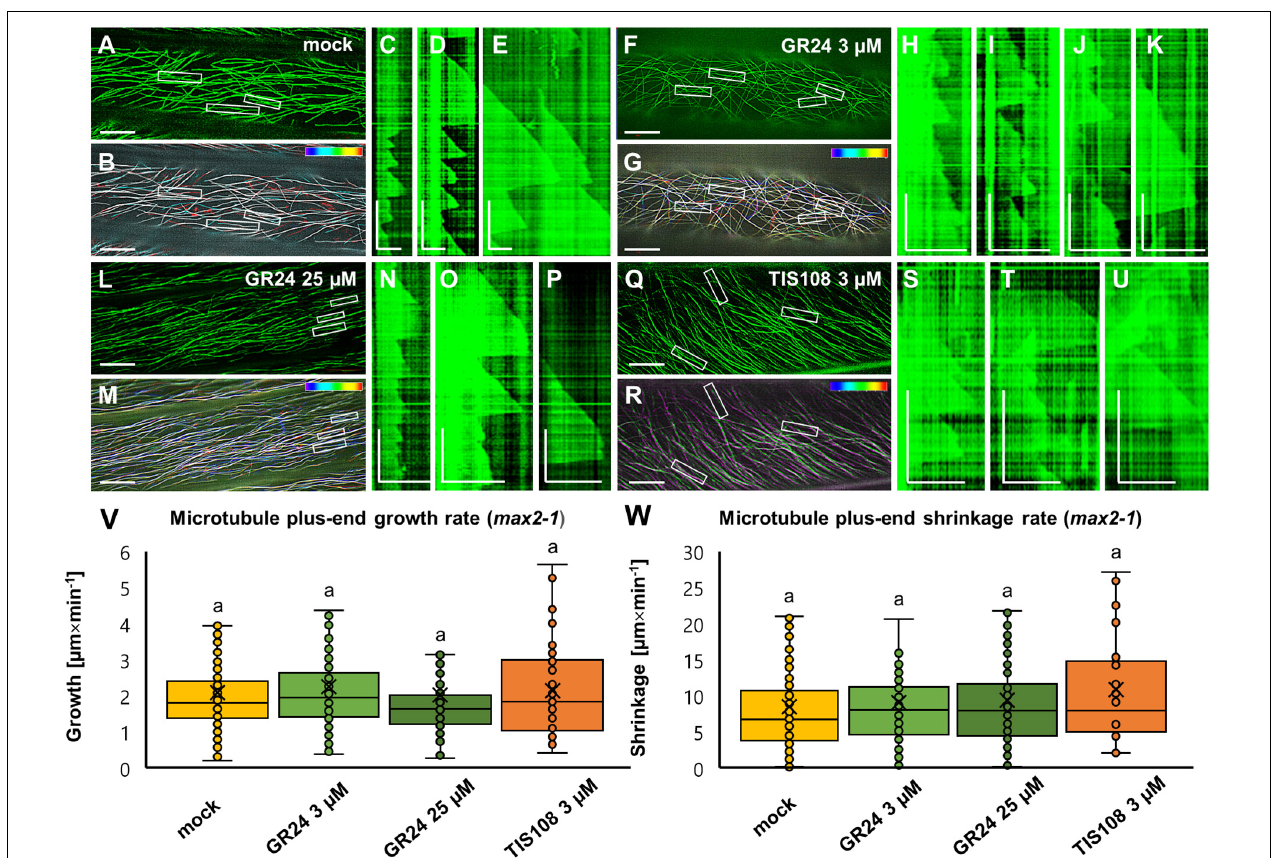
FIGURE 8 | Analysis of microtubule dynamics of Arabidopsis max2-1 mutant expressing the GFP-MBD microtubule marker in the presence or absence of the synthetic strigolactone GR24 (3 µ M and 25 µ M) or the biosynthetic inhibitor of strigolactone production TIS108 (3 µ M). (A,B) Overview (A) and color-coded projection (B) of the time series corresponding to mock-treated max2-1 ( Supplementary Movie 5 ). (C,D,E) Three kymographs showing microtubule length fluctuations corresponding to boxed areas 1,2,3 of panels (A,B) , indicative of slower and prolonged growth and shrinkage compared to Col-0. (F,G) Overview (F) and color-coded projection (G) of the time series corresponding to max2-1 treated with 3 µ M GR24 ( Supplementary Movie 6 ). (H–K) Four representative kymographs from boxed areas 1,2,3 and 4 of panels (F,G) showing similar microtubule dynamics as in mock-treated cells. (L,M) Overview (L) and color-coded projection (M) of the time series corresponding to max2-1 treated with 25 µ M GR24 ( Supplementary Movie 7 ). (N–P) Three representative kymographs from boxed areas 1, 2, and 3 of panels (L,M) showing comparable growth and shrinkage to mock-treated cells. (Q,R) Overview (Q) and color-coded projection (R) of the time series corresponding to max2-1 treated with 3 µ M TIS108 ( Supplementary Movie 8 ). (S–U) Three representative kymographs from boxed areas 1, 2, and 3 of panels (Q,R) . (V,W) Quantitative assessment of microtubule growth [ (V) ; N ≥ 41; Welch’s ANOVA showed no statistically significant difference within the dataset; F (3, 601) = 0.6081, p = 0.6106] and shrinkage [ (W) ; N ≥ 20; Welch’s ANOVA showed no statistically significant difference within the dataset; F (3, 333) = 80.2659, p = 0.6649] of GFP-MBD labeled microtubule in all experimental conditions. In all box plots, the average is presented by × , median by the middle line, 1 st quartile by the bottom line, 3 rd quartile by the top line; the whiskers lie within the 1.5 × interquartile range (defined from the 1 st to the 3 rd quartiles) while outliers are omitted. Scale bars: 10 µ m (A,B,F,G,L,M,Q,R) ; 5 µ m (H–K,N–P,S–U) ; 2 µ m (C–E) . All time bars correspond to 2 min.